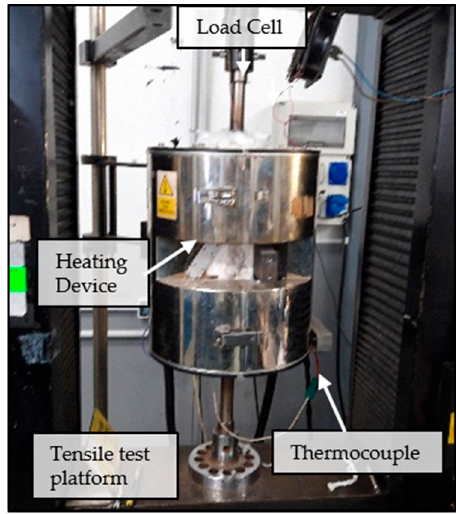
Figure 3. Experimental setup and heating device.